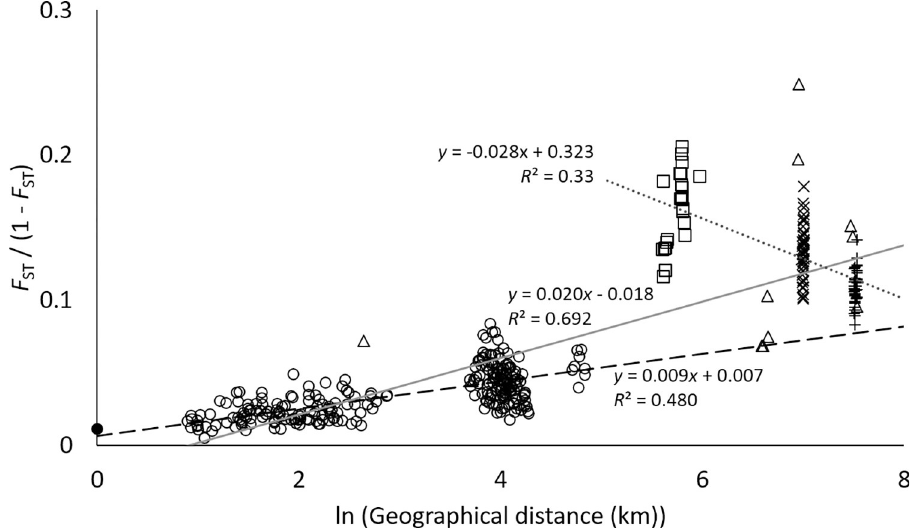
Fig 4. Relationship between pairwise genetic differentiation and natural logarithms of geographical distance for all the 27 P . obovata var. obovata and one P . obovata var. dubia populations. Solid circle, population pair between P . obovata var. obovata (CC4) and P . obovata var. dubia (CC4_dubia); open circles, population pairs within the Bonin Islands; squares, population pairs between the Bonin and Volcano Islands; cross signs, population pairs between the Bonin and Daito Islands; plus signs, population pairs between the Bonin and Yaeyama Islands; triangles, population pairs between other islands; solid gray line, regression line for all 28 populations; black broken line, regression line for population pairs within the Bonin Islands; gray dotted line, regression line for population pairs whose geographical distance over 270 km (ln (1 + geographical distance > 5.6)).